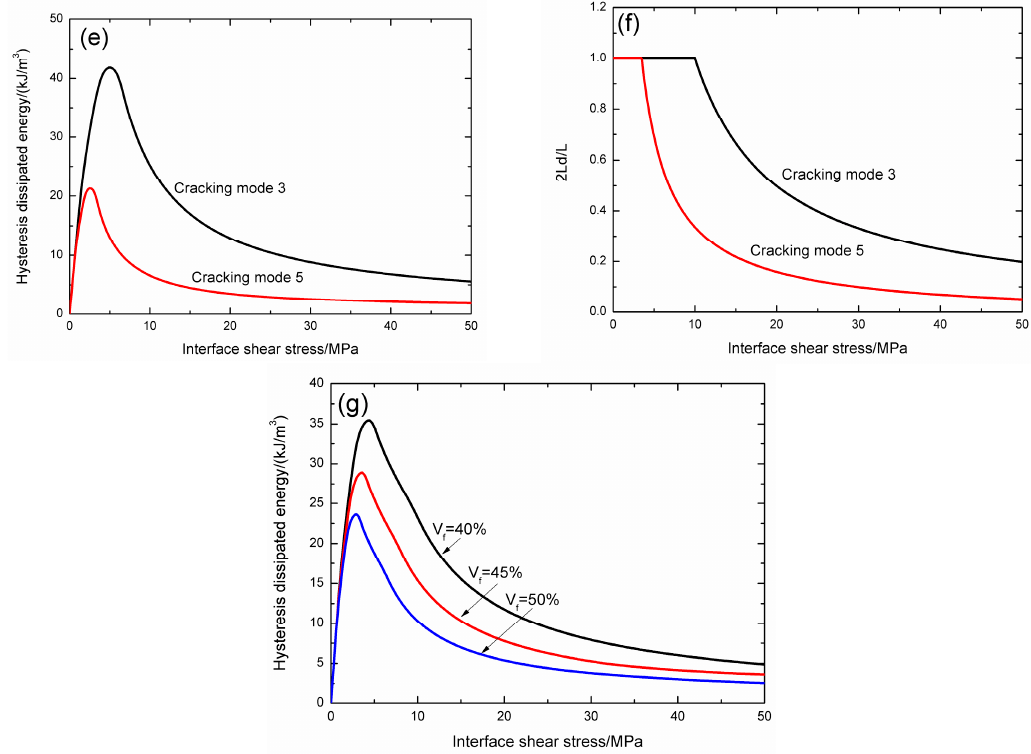
Figure 3. ( a ) The hysteresis dissipated energy versus interface shear stress curves of matrix cracking mode 3 and mode 5 when V f = 40%; ( b ) the interface debonded length 2 L d / L versus interface shear stress curves of matrix cracking mode 3 and mode 5 when V f = 40%; ( c ) the hysteresis dissipated energy versus interface shear stress curves of matrix cracking mode 3 and mode 5 when V f = 45%; ( d ) the interface debonded length 2 L d / L versus interface shear stress curves of matrix cracking mode 3 and mode 5 when V f = 45%; ( e ) the hysteresis dissipated energy versus interface shear stress curves of matrix cracking mode 3 and mode 5 when V f = 50%; ( f ) the interface debonded length 2 L d / L versus interface shear stress curves of matrix cracking mode 3 and mode 5 when V f = 50%; and ( g ) the composite hysteresis dissipated energy versus interface shear stress curve when V f = 40%, 45% and 50%, and η = 0.2.